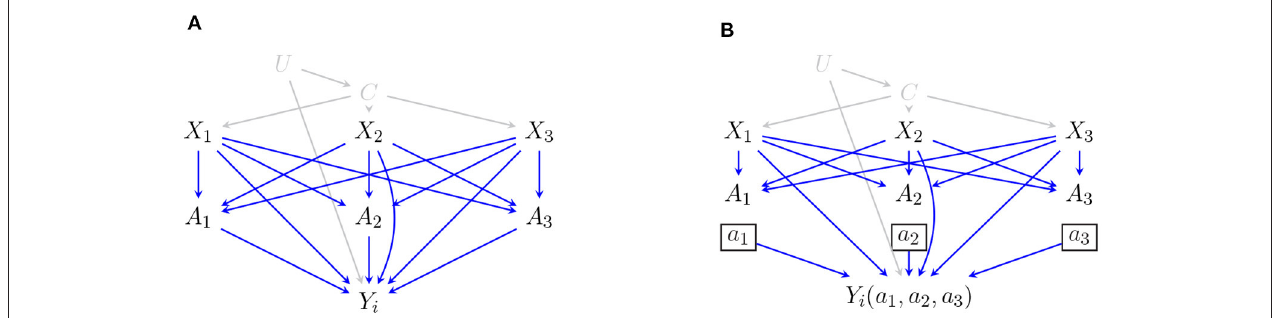
FIGURE 1 | (A) DAG representation of the SEM in Equation (1) for a pageview with three impressed ads (the independent error terms are omitted from the graph for simplicity). (B) The corresponding SWIG where we intervene on A and set the block allocations ( A 1 , A 2 , A 3 ) to ( a 1 , a 2 , a 3 ).